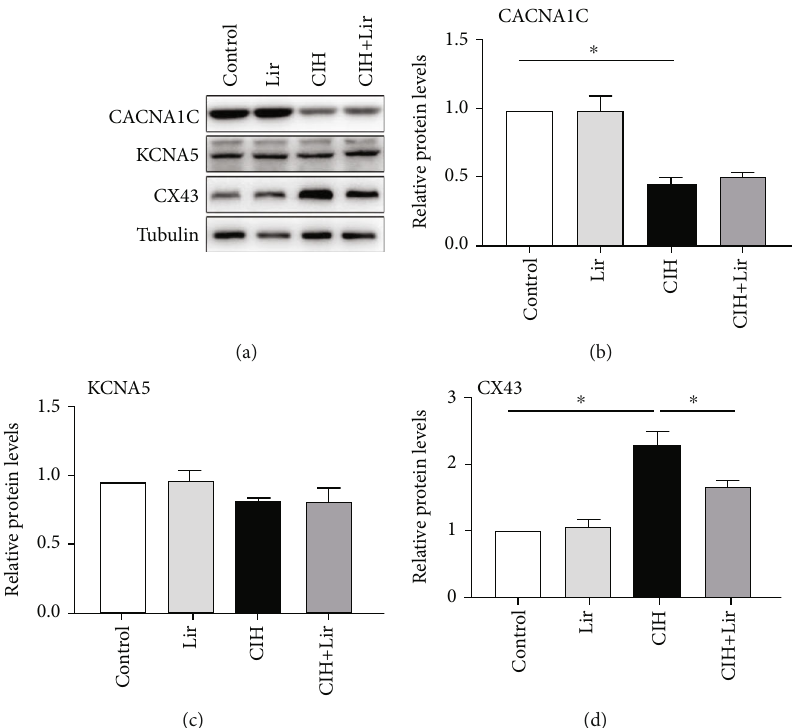
Figure 7: The e ff ect of Lir on the atrial electrical remodeling. (a – d) Western blot analysis of protein levels of CACNA1C, KCNA5, and CX43 (connexin 43) ( n = 6 ). The increase in CX43 caused by CIH was ameliorated following Lir administration. Data are mean ± SEM , ∗ P < 0 : 05